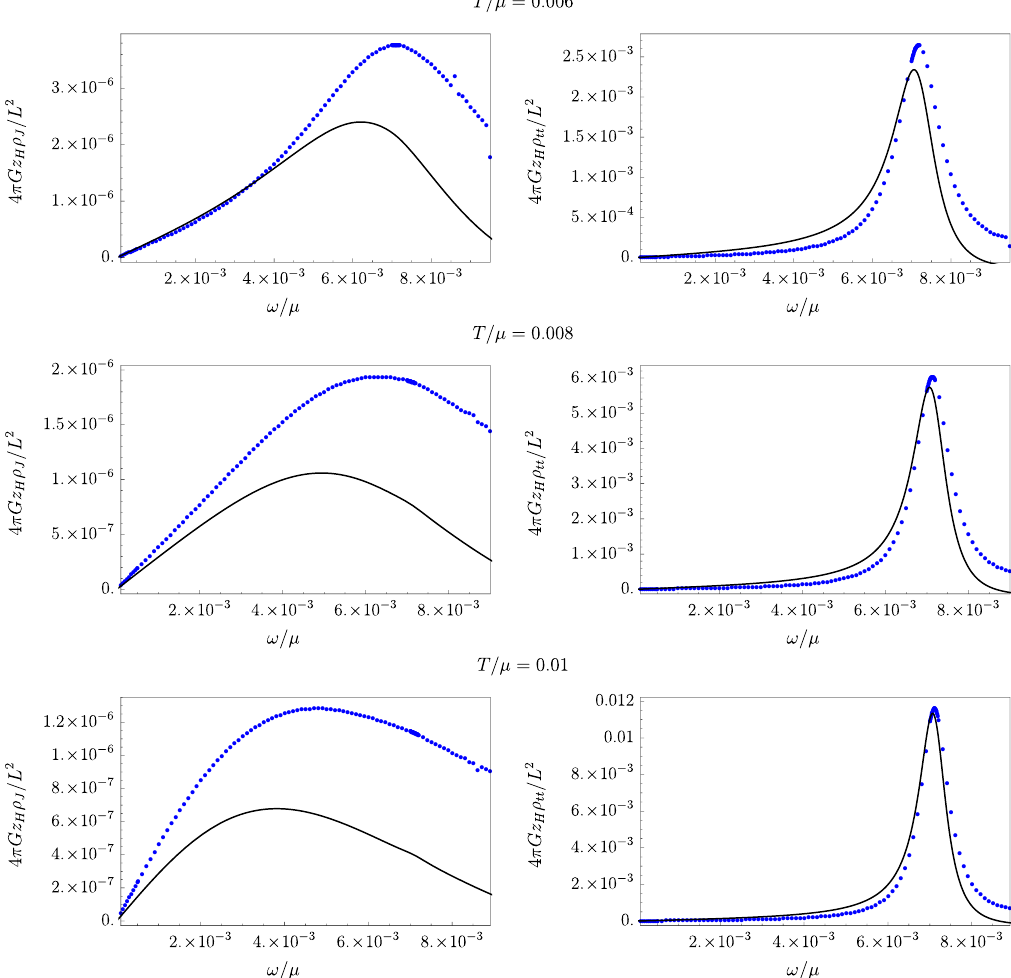
Figure 17. Our numerical results (blue dots) for the charge spectral function, (cid:26) J (left column) and energy spectral function, (cid:26) tt (right column), each made dimensionless by a factor of 4 (cid:25)Gz H =L 2 , as functions of !=(cid:22) for (cid:28) = 10 (cid:0) 4 , ~ (cid:11) = 0 : 1, k=(cid:22) = 10 (cid:0) 2 and T=(cid:22) = 6 (cid:2) 10 (cid:0) 3 (top row), 8 (cid:2) 10 (cid:0) 3 (middle row), and 10 (cid:0) 2 (bottom row). The solid black lines come from the sum-of-poles approximation to the Green’s functions in eq. (3.6). As T=(cid:22) increases, the behavior of (cid:26) tt is qualitatively the